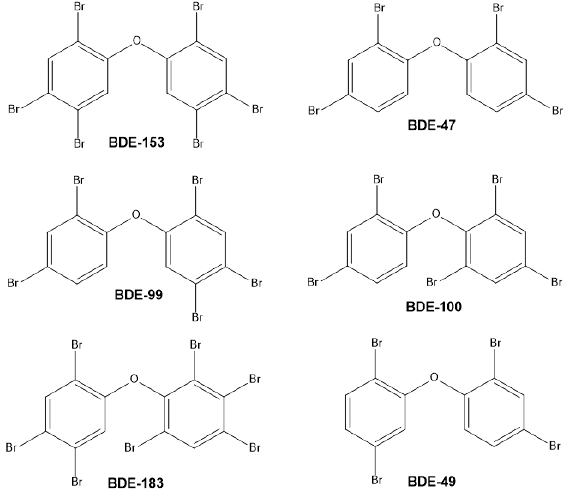
Figure 2. The commonest PBDE congeners found in human fat tissue. Table 3. Overall level of PBDEs, PCBs, and DDTs in human fat tissue in ng / g of fat and comparison with previous studies for the Czech Republic published in 2009 [39]. Current Study ( n = 107) Previous Study ( n = 98)